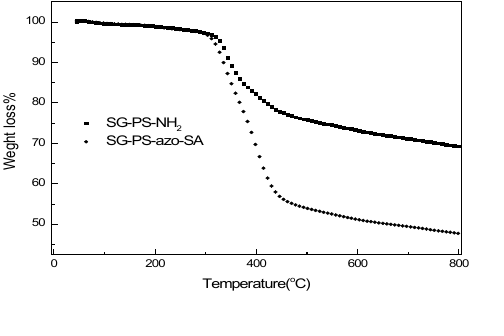
Figure 3. TGA of SG-PS-NH 2 and SG-PS-azo-SA Figure 4. The saturated adsorption capacities of SG-PS-azo-SA for metal ions with the initial concentration of all metal